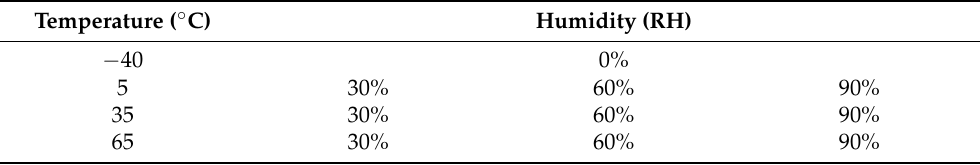
Table 1. The GDJ-1000B internal environment temperature and humidity